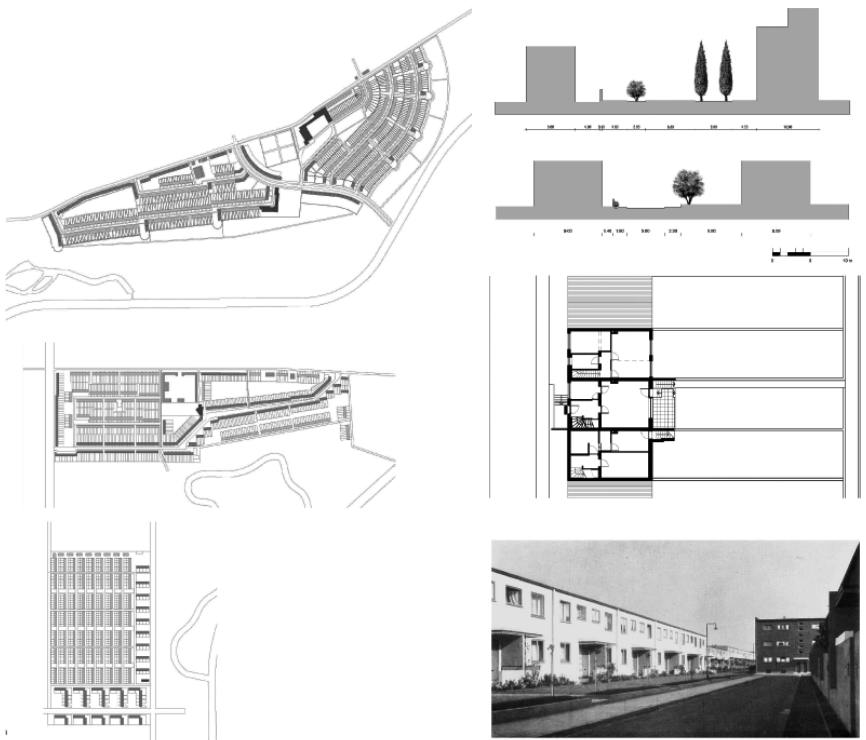
Figure 17. Frankfurt am Main. Left, from top to bottom: Site plan of the Siedlungen Römerstadt, Praunheim and Westhausen. Right, from top to bottom: Cross section of Hadrianstraße and Am Burgfeld in the Siedlung Römerstadt; floorplans of the house types A and D of Im Burgfeld; photo of the street. Source: Michieletto, (2008). sents, however, the opposite of the experience of Das neue Frankfurt : the Dom-Römer “reconstruction”.